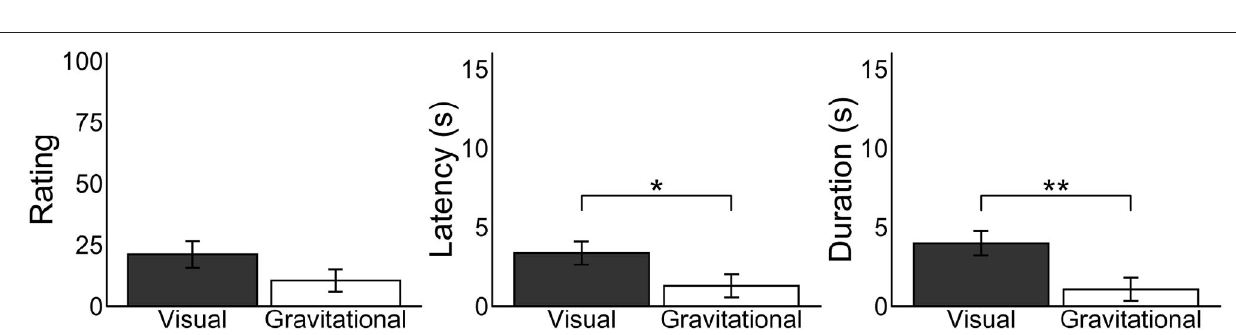
FIGURE 6 | Mean differences of vection measures for each vertically divided and laterally divided visual field in the recumbent position. Bar plots in the visual condition represent differences of vection responses between the UVF and LoVF conditions in the recumbent position for each participant, representing the effects of the retinotopically lower visual field. Bar plots in the gravitational condition represent differences of vection responses between the UGVF and LGVF conditions in the recumbent position for each participant, representing the effects of the gravitationally lower visual field. Error bars represent standard error of the mean * p < 0.05, ** p <